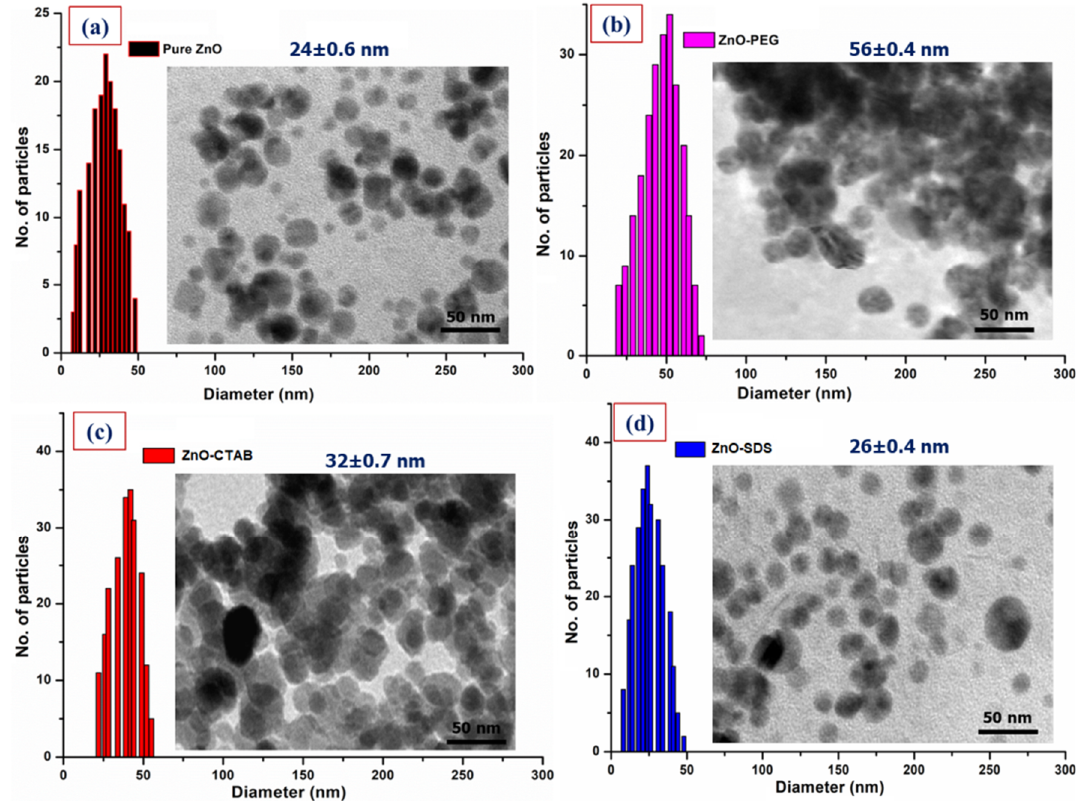
Figure 3. HRTEM analysis of all four ZnO NPs along with the size distribution, ( a ) Pure ZnO, ( b ) ZnO–PEG, ( c ) ZnO–CTAB, and ( d ) ZnO–SDS. ( b ) ZnO–PEG, ( c ) ZnO–CTAB, and ( d )